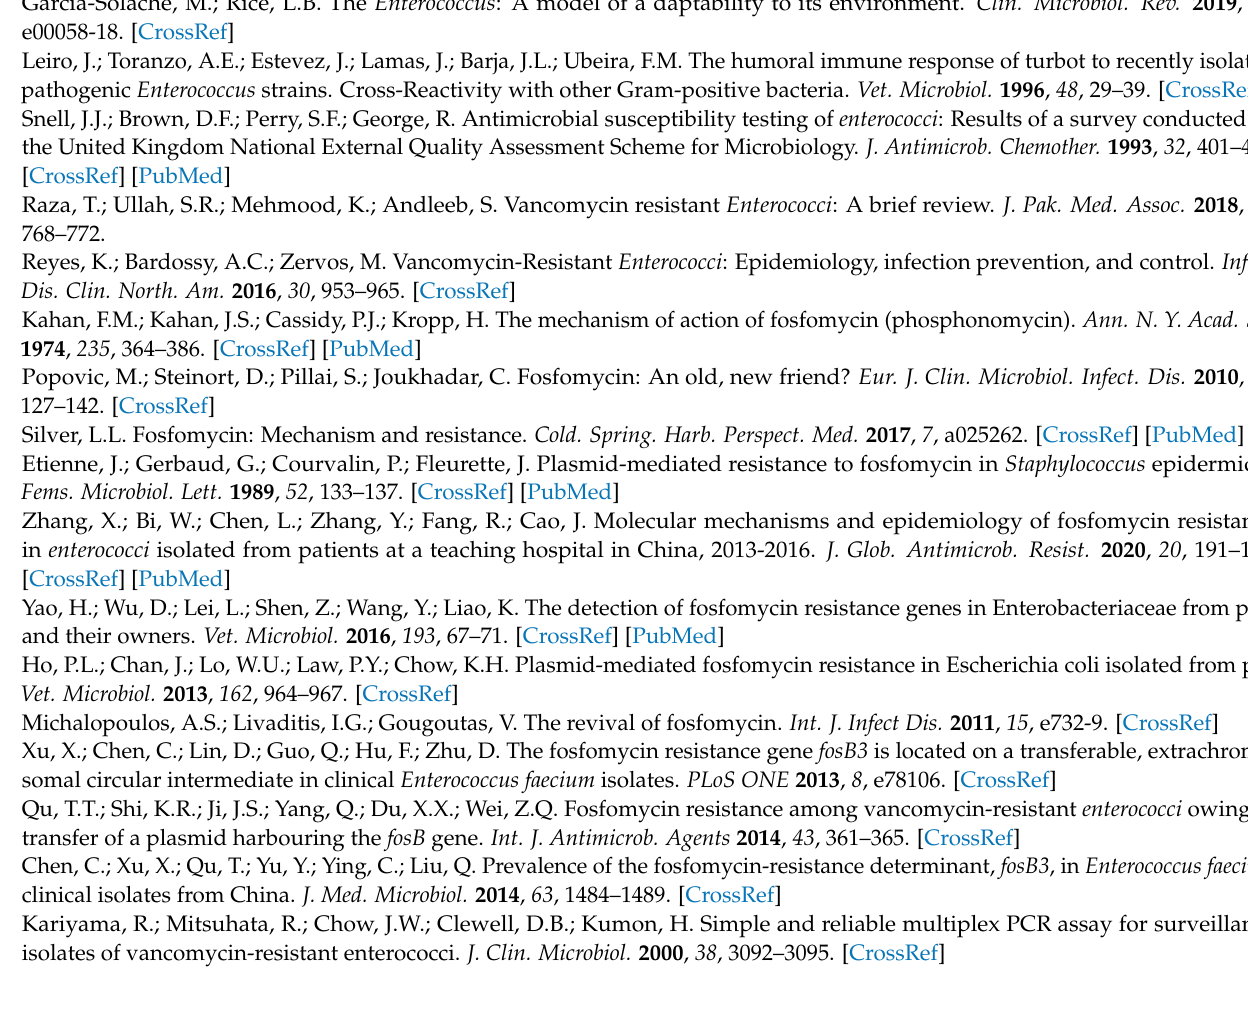
Generator, Figure S2: Genetic environment of optr A. Schematic representation and comparison of the genetic environment of the optr A-flanking region from this study and previous reported. Arrows indicate the direction of transcription of each of the genes, and different genes are shown in different colors. Regions of ≥ 70.0% nucleotide sequence identity are shaded in